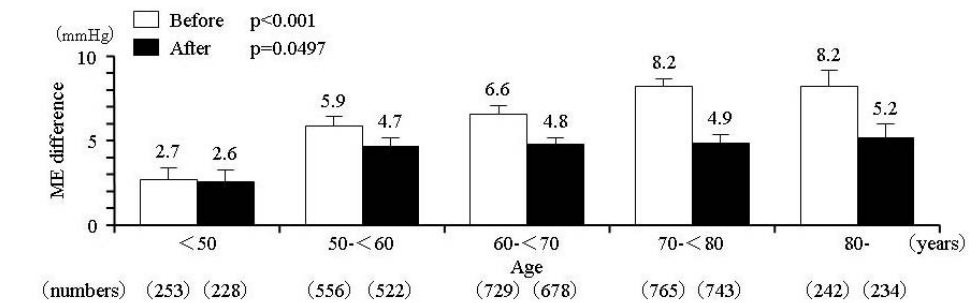
White column, before treatment; black column, after treatment with AZ. Numbers above each column indicate each ME-Dif. Numbers in parenthesis indicate no. patients. The p-values indicate significances in ANOVA comparison before versus after treatment with AZ. ME-Dif before treatment was significantly (p < 0.001) increased with age, whereas the age-related increase in ME-Dif was minimized after treatment with AZ. Values are mean ±